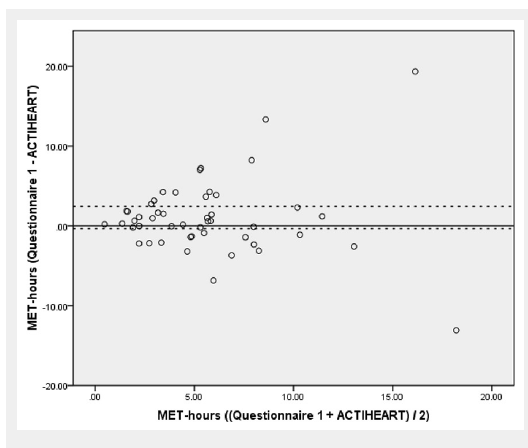
Bland-Altman plot of self-reported (questionnaire 1) minus measured (ACTIHEART) MET-hours (vertical axis) against mean of self-reported and measured MET-hours (horizontal axis). The solid horizontal line corresponds to the mean difference (1.05 MET- hours) while the dashed horizontal lines correspond to the 95% confidence interval (–0.34 to 2.44 MET-hours) (n =